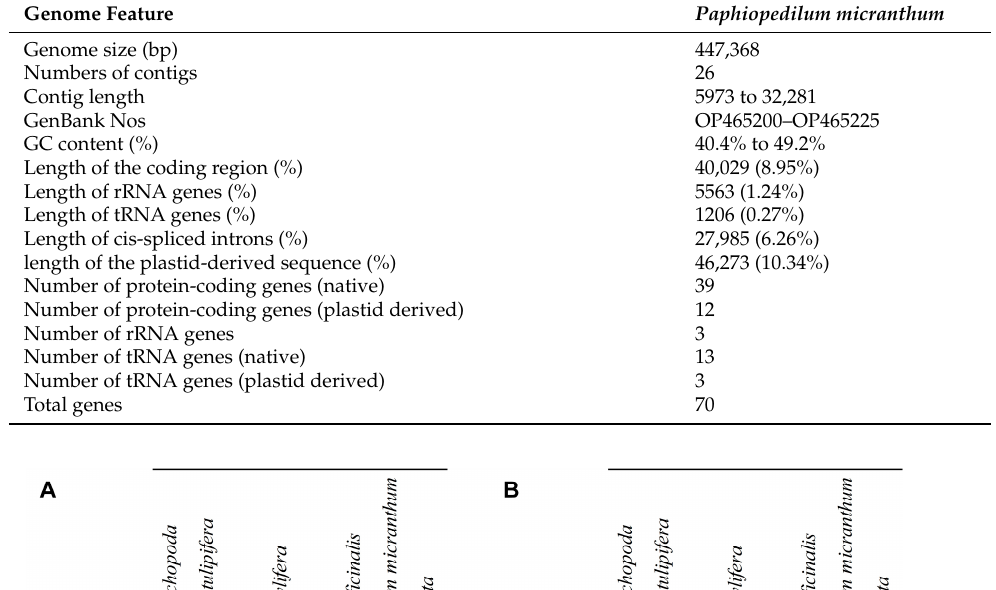
Table 1. General features of the mitogenome of Paphiopedilum micranthum .